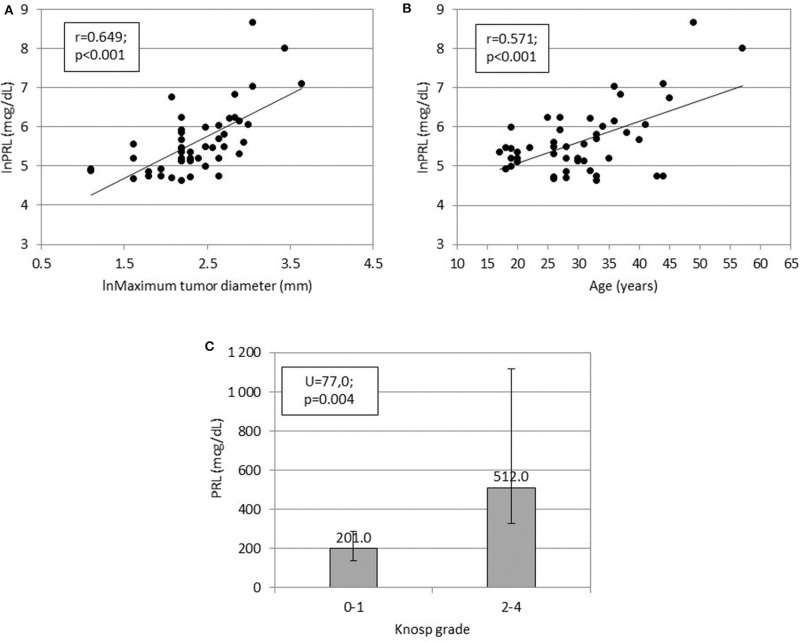
Relationships between (A) serum prolactin concentration (ln) and prolactinoma size (ln), (B) serum prolactin concentration (ln) and patients' age, and (C) serum prolactin concentration and Knosp grade.